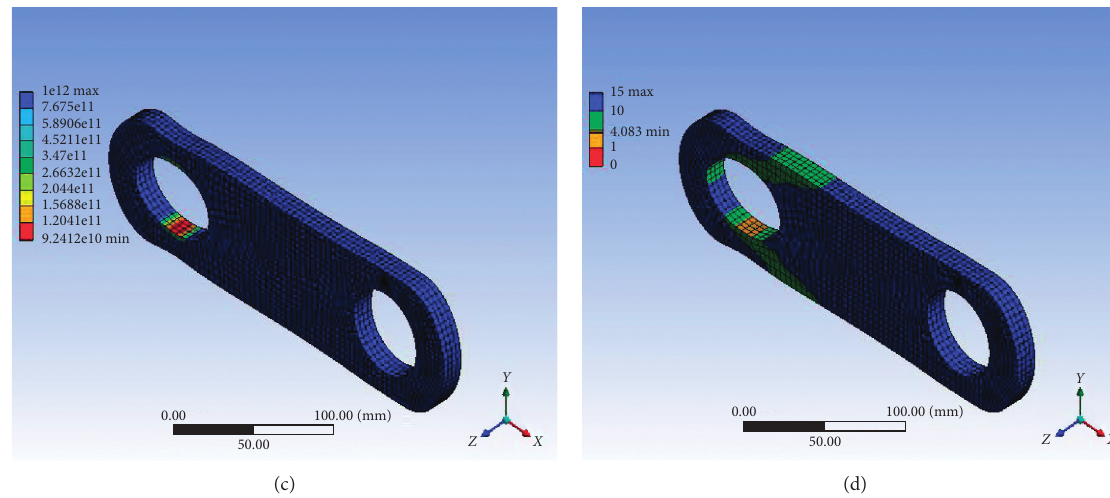
Figure 15: Simulation results for chain link with a modeled crack and neck radius 621.5mm ( X � 2mm): (a) equivalent stress, (b) deformation, (c) fatigue life, and (d) safety factor.